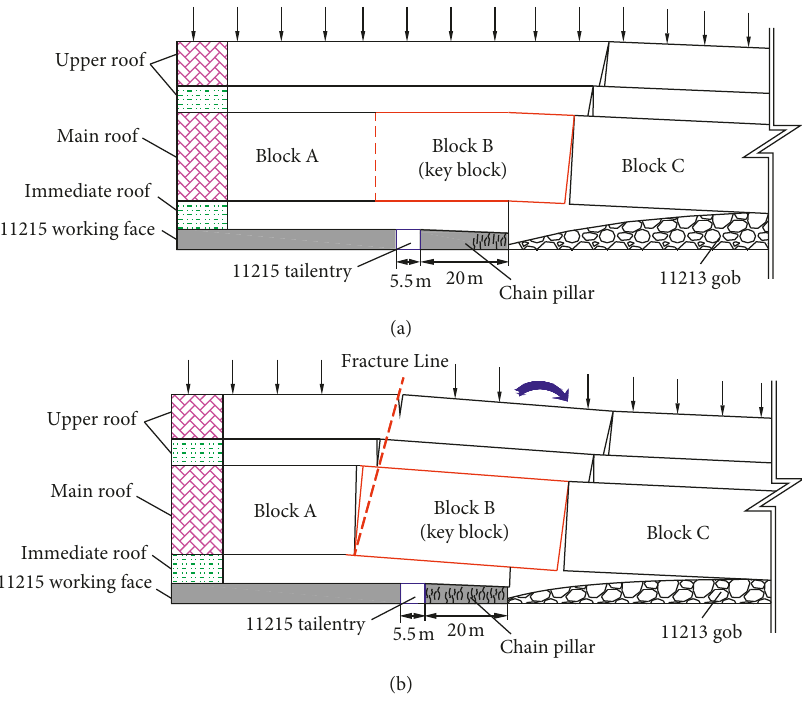
Figure 10: Structure of the lateral main roof under PMI and SMI. (a) PMI. (b) SMI.